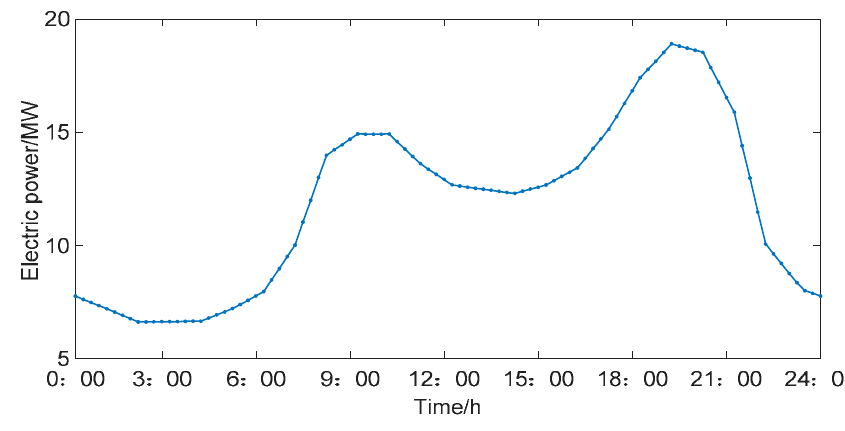
Figure 6. The curve of power load.